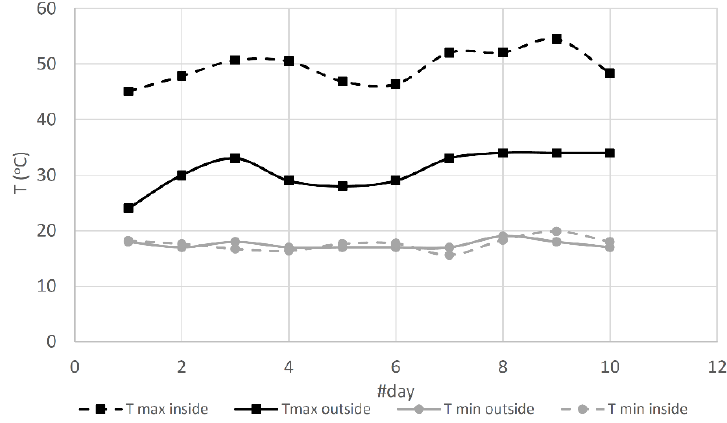
Figure 3. Temperature distribution in the prototype (outside and inside).